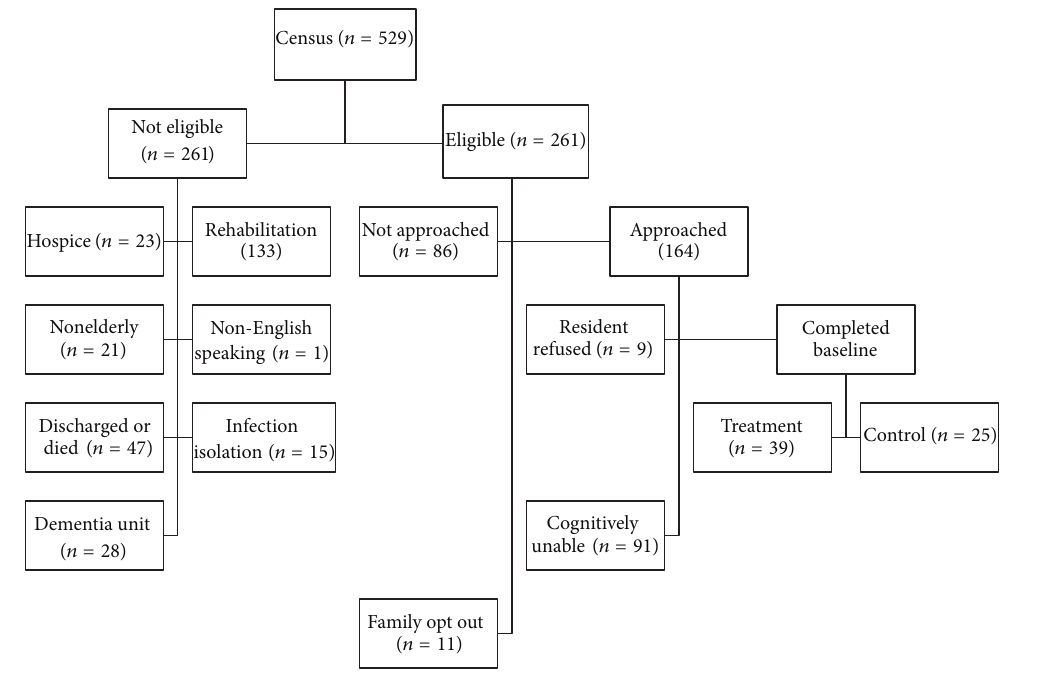
Figure 1: Sample